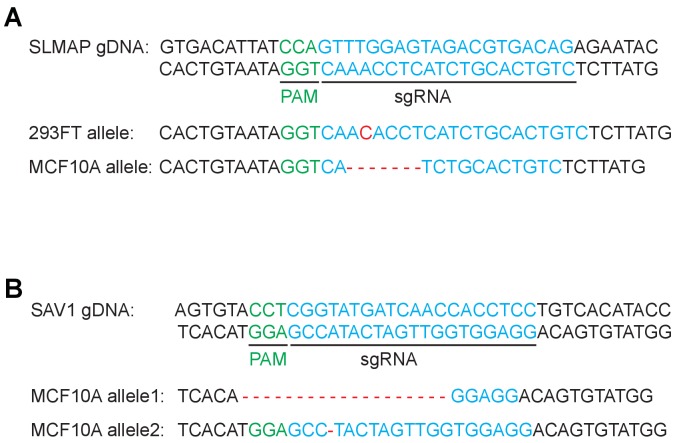
CRISPR/Cas9-induced indel mutations in MCF10A and 293FT cells.(A and B) Intact genomic sequences of SLMAP and SAV1 are shown in the top panels. The indel mutations in SLMAP KO or SAV1 KO cells are shown in the bottom panels.